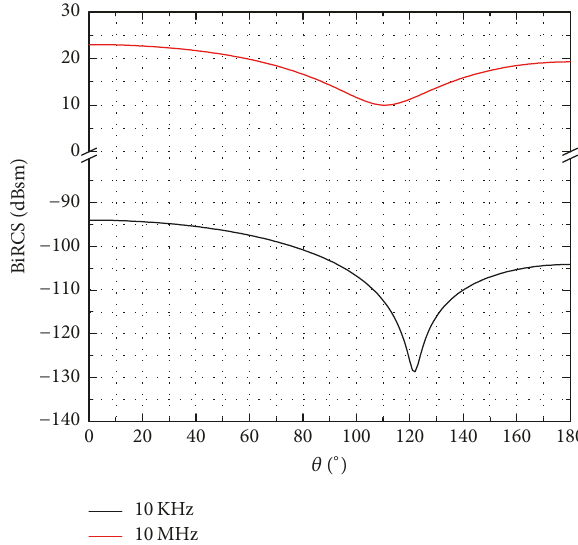
Figure 8: Bistatic RCS of the PEC cone at 10KHz and